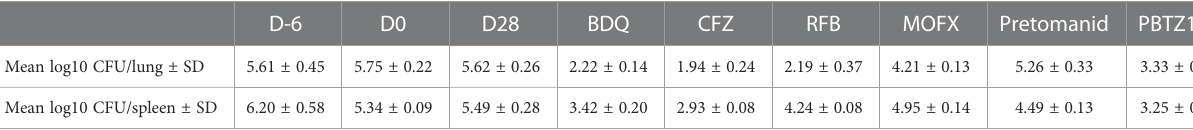
TABLE 5 M. chelonae burden in the lungs and spleens of mice.